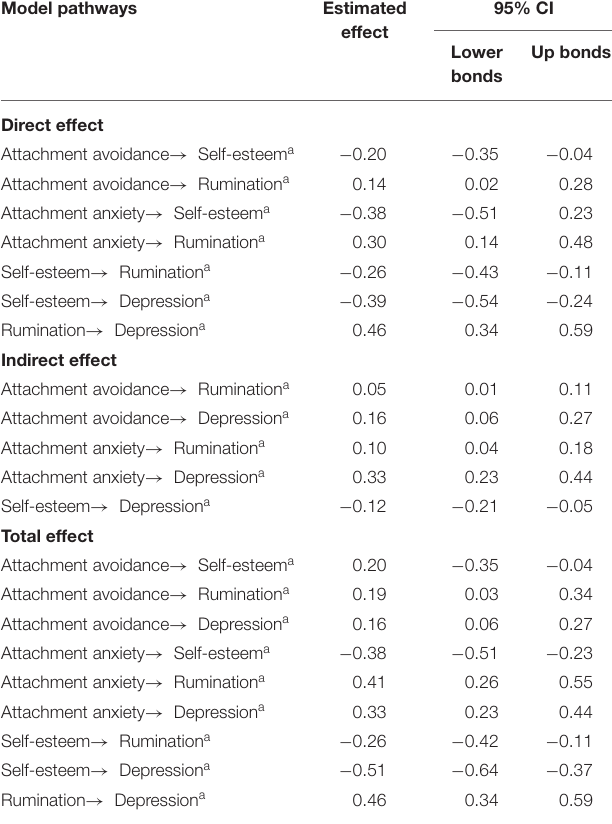
TABLE 3 | Standardized effect and 95% CIs for the final